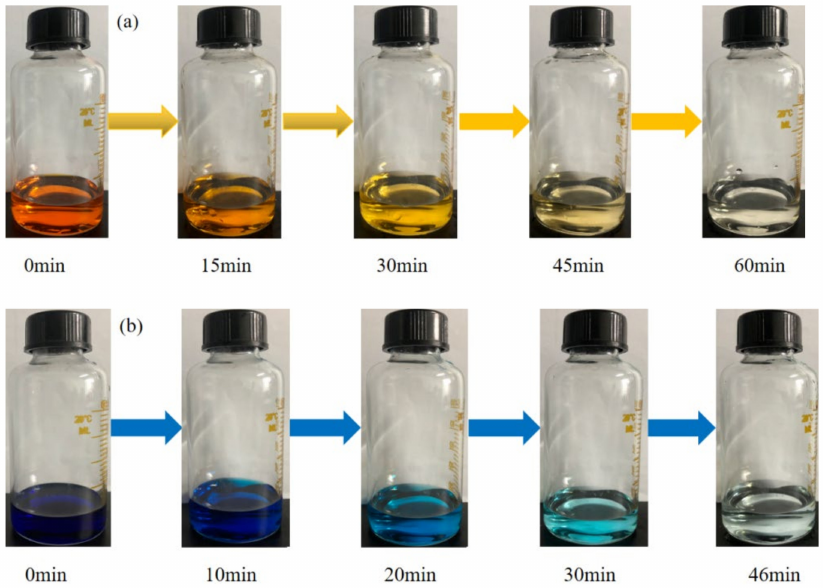
Figure 5. Photographs of ( a ) MO and ( b )MB solutions with color changed form heavy to clear catalytically degraded with nano-PAA-CuCl2 composite/H 2 O 2 system.